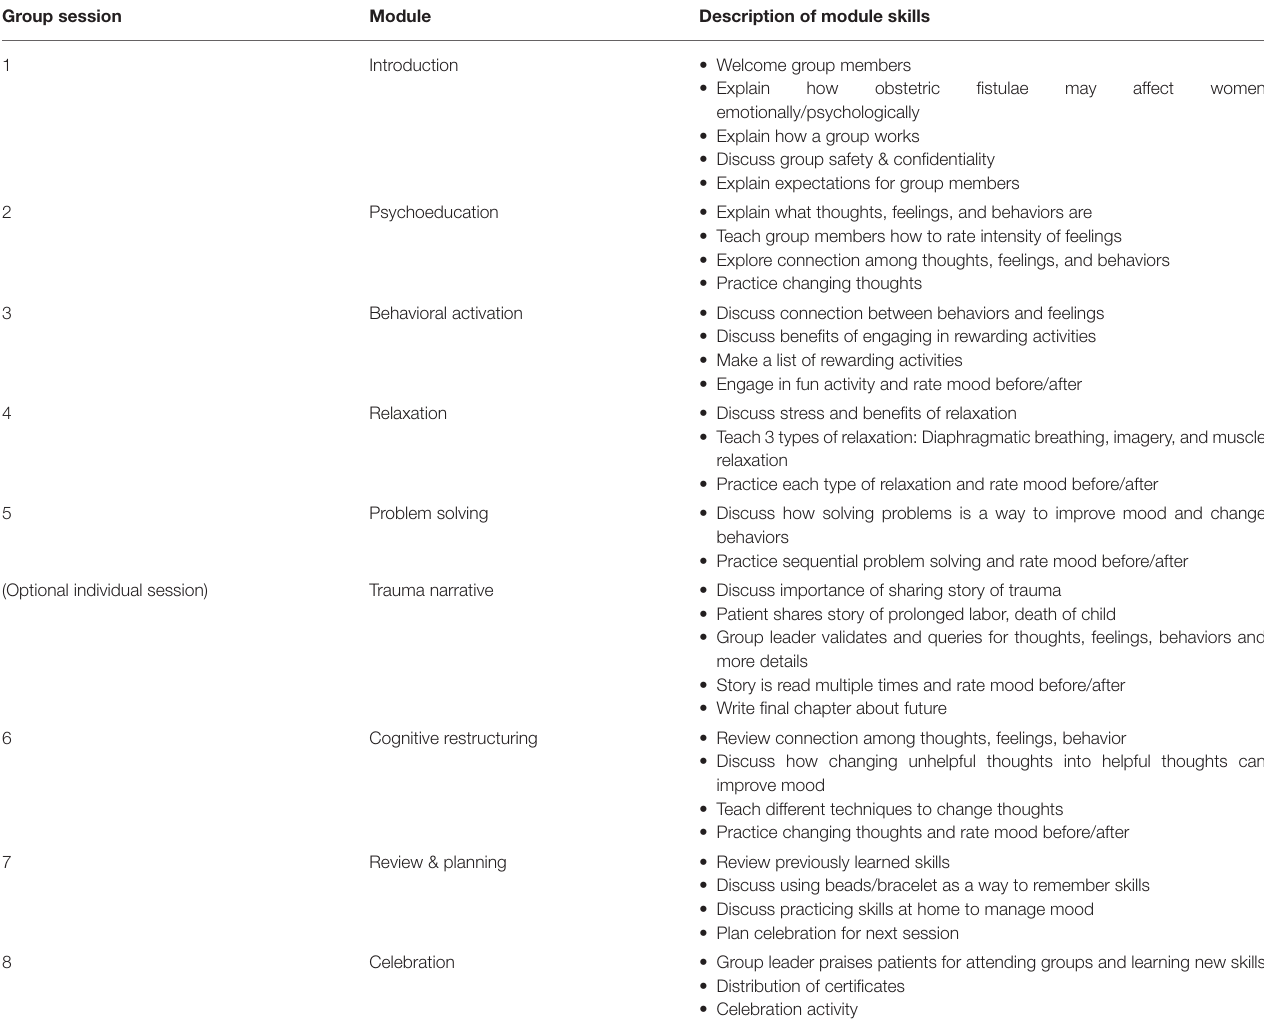
TABLE 1 | Fistula group CBT session descriptions and skills. Group session Module Description of module